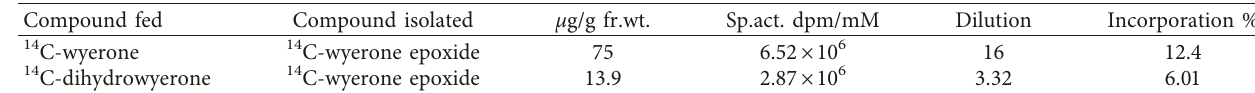
Table 3: Incorporation data of 14 C-labelled wyerone and 14 C-dihydrowyerone into 14 C-wyerone epoxide (according to Section 2.5). Compound